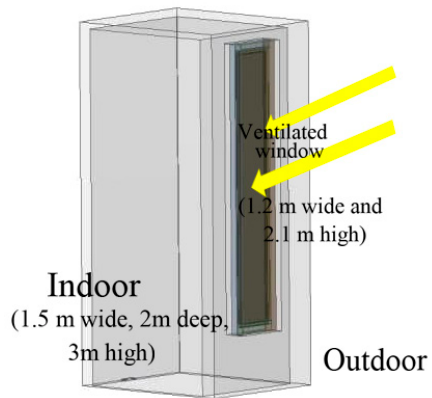
Figure 3. Computational domain.